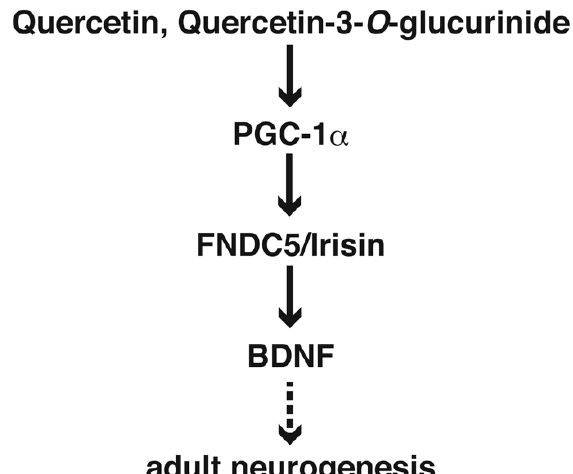
Figure 3. Quercetin and its metabolite may induce adult neurogenesis through the PGC-1 α -FNDC5 /Irisin-BDNF cascade.